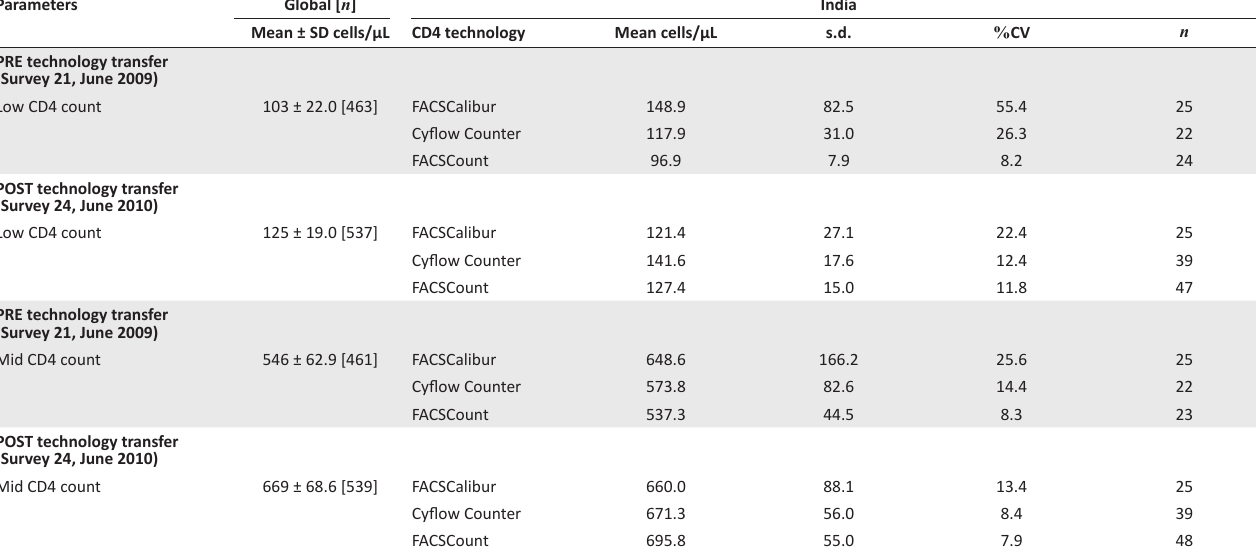
TABLE 1: Performance of specific CD4 technologies in India for low- and mid-level CD4 count controls at pre- and post-technology transfer.